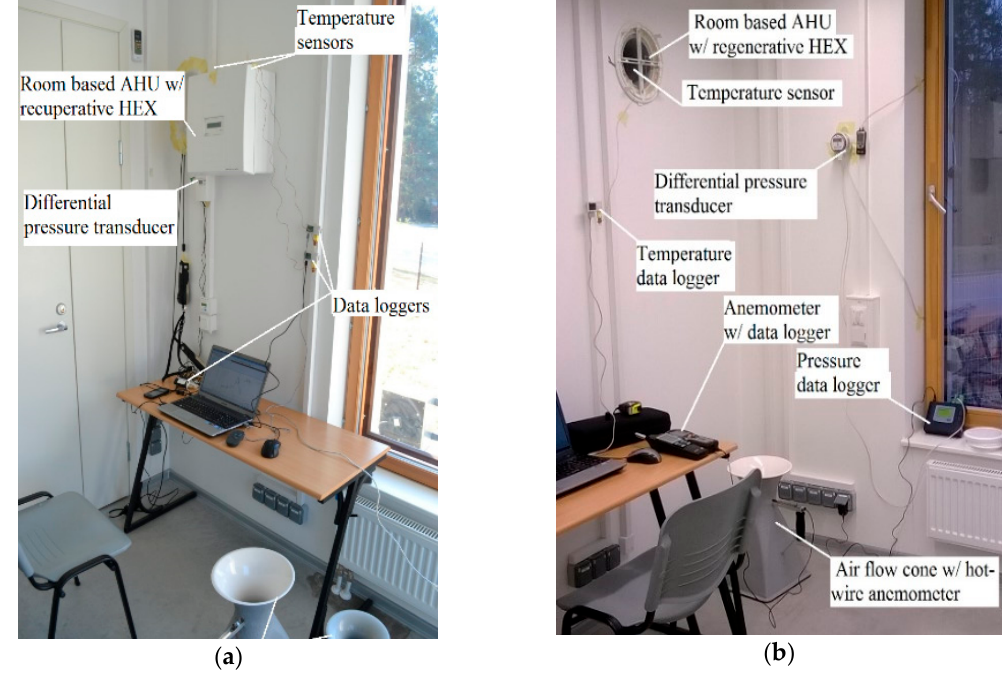
Figure 5. Experimental setup with the studied room-based ventilation units: ( a ) with recuperative HEX and ( b ) regenerative HEX.